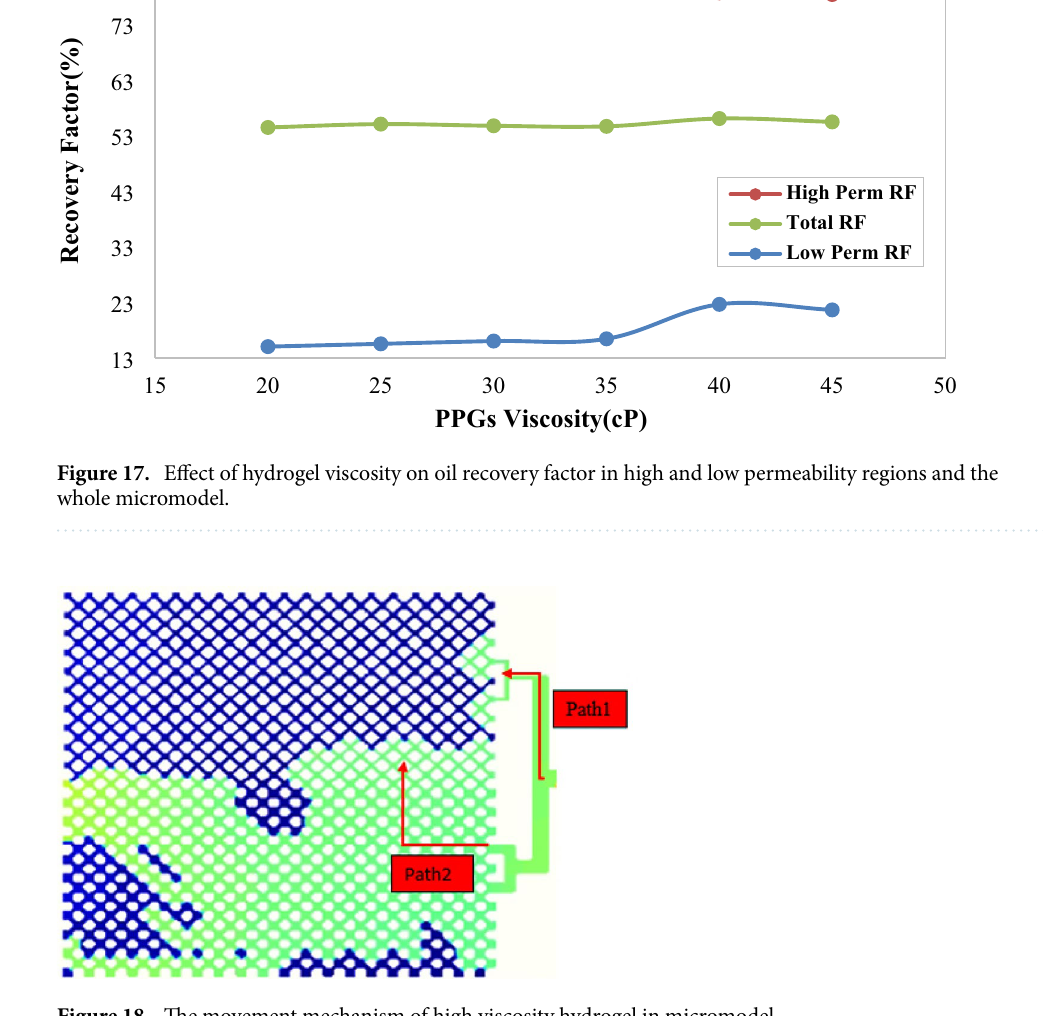
Figure 18. The movement mechanism of high viscosity hydrogel in micromodel.